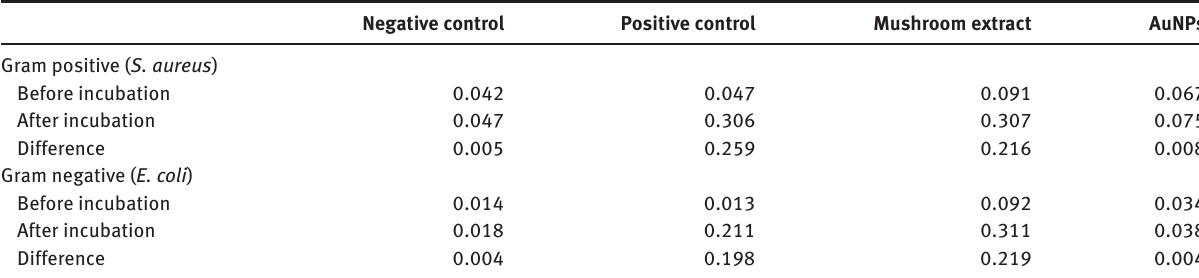
Table 4: Growth inhibition activity of the synthesized AuNPs against S. aureus (Gram-positive) and E. coli (Gram-negative). Negative control Positive control Mushroom extract AuNPs Gram positive ( S. aureus